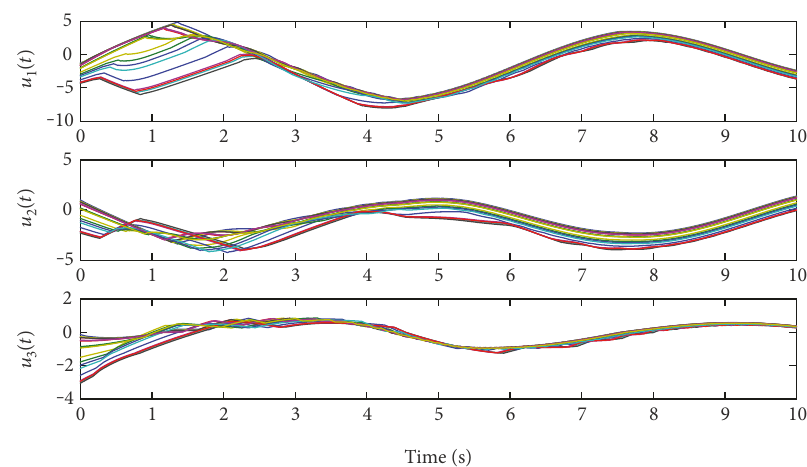
Figure 5: Virtual de fl ection angle control commands for the fi rst three SJA arrays (i.e., u